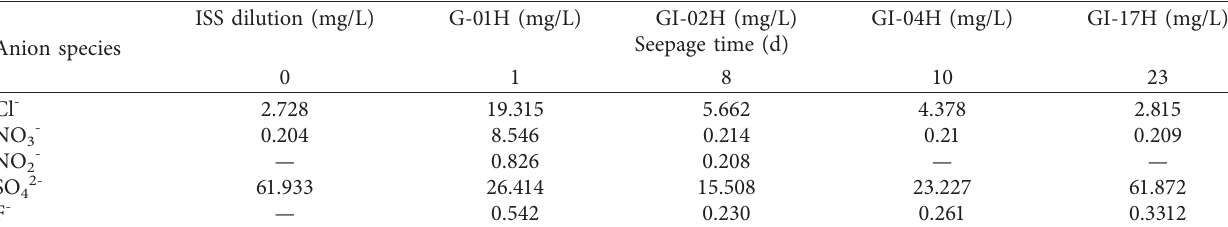
Table 8: Concentration of main anions from the exudate in different periods.